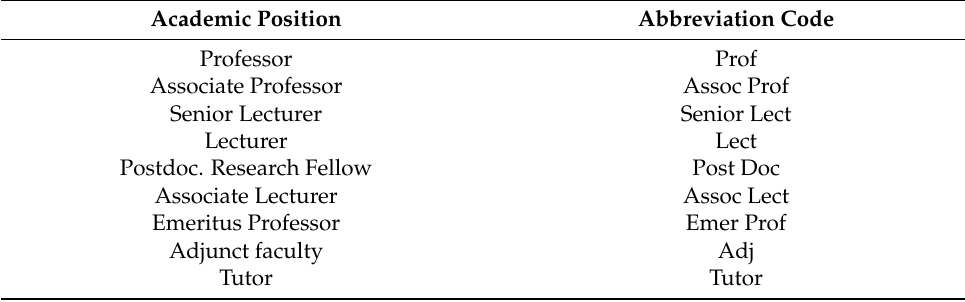
Table 2. Abbreviation codes for academic position in Australia/New Zealand.